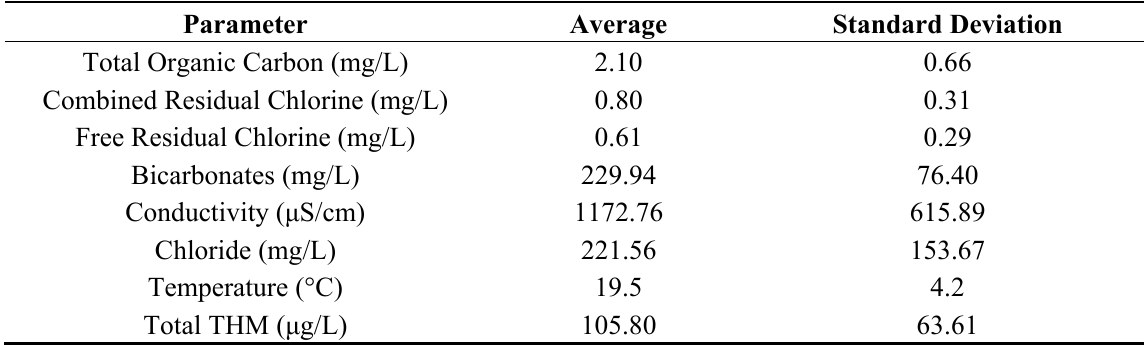
Table 1. Summary of most significant parameters measured in the 892 network water